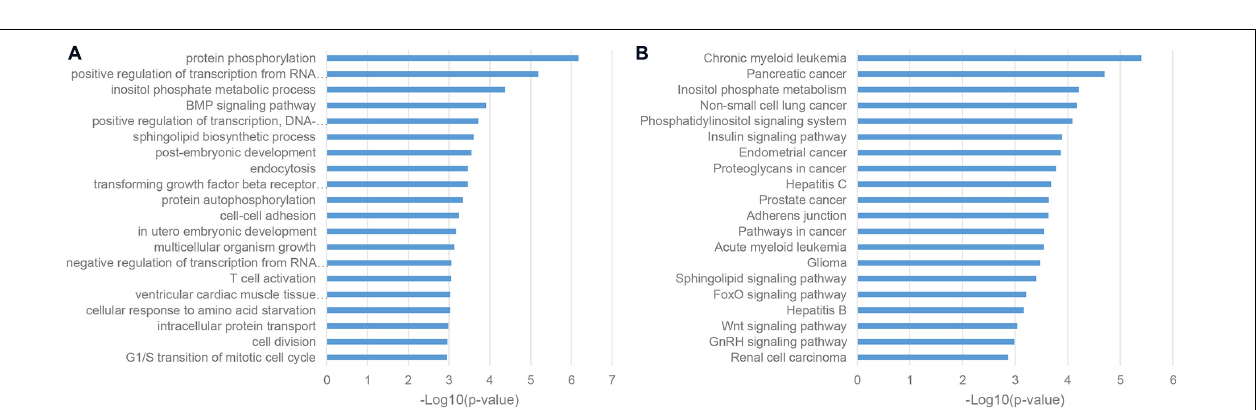
FIGURE 2 | Enriched functional terms of genomic neighbors of ASD-related lncRNAs. (A) The top 20 gene ontology biological process (GO BP) terms with p -value < 0.05. (B) KEGG pathway terms with p -value < 0.05.